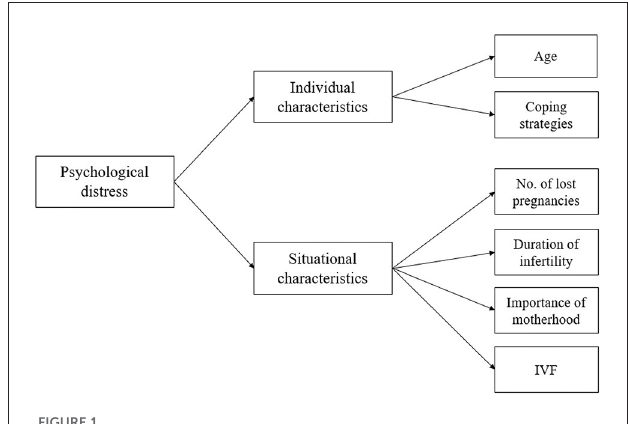
FIGURE1 The proposed conceptual framework, based on Zurlo et al. (49).